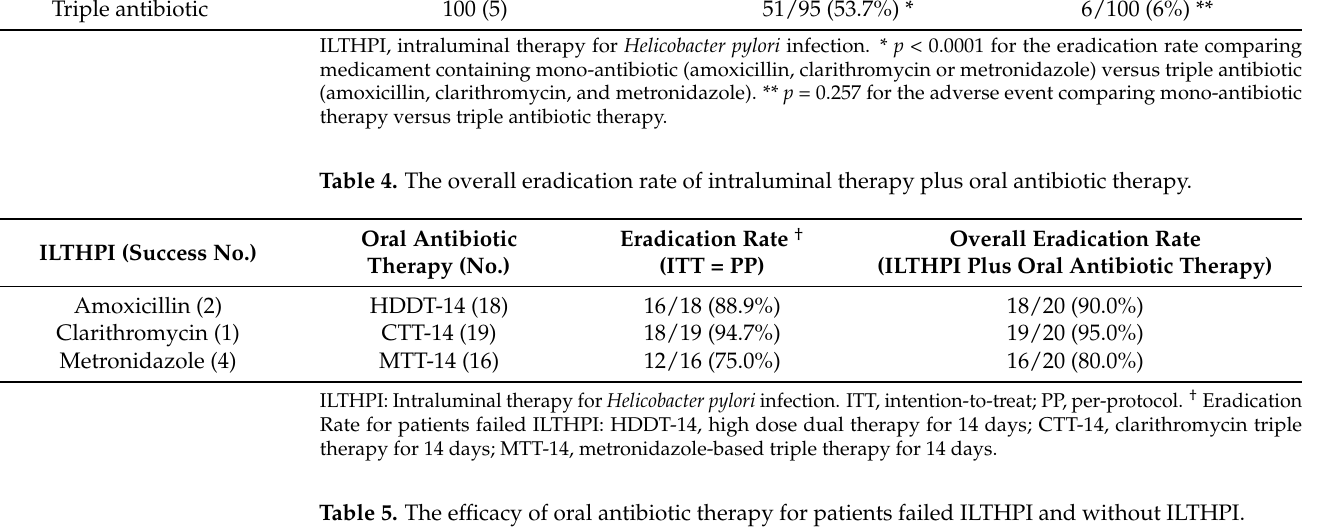
Table 5. The efficacy of oral antibiotic therapy for patients failed ILTHPI and without